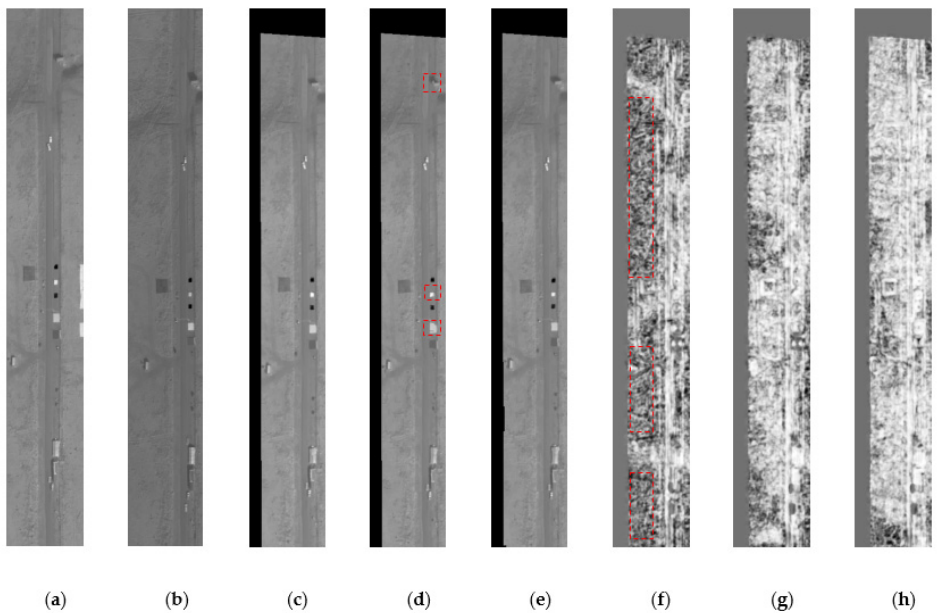
Figure 11. ( a , b ) Brightness temperature (BT) maps for LWIR1 a and LWIR1 b . ( c – e ) Transformed images with global homography, after blockwise refinement, and after pixelwise refinement, respectively. ( f – h ) Corresponding SSIM maps between the transformed image and reference image (BT map of LWIR1 b ) for global homography, blockwise refinement, and pixelwise refinement, respec- tively.